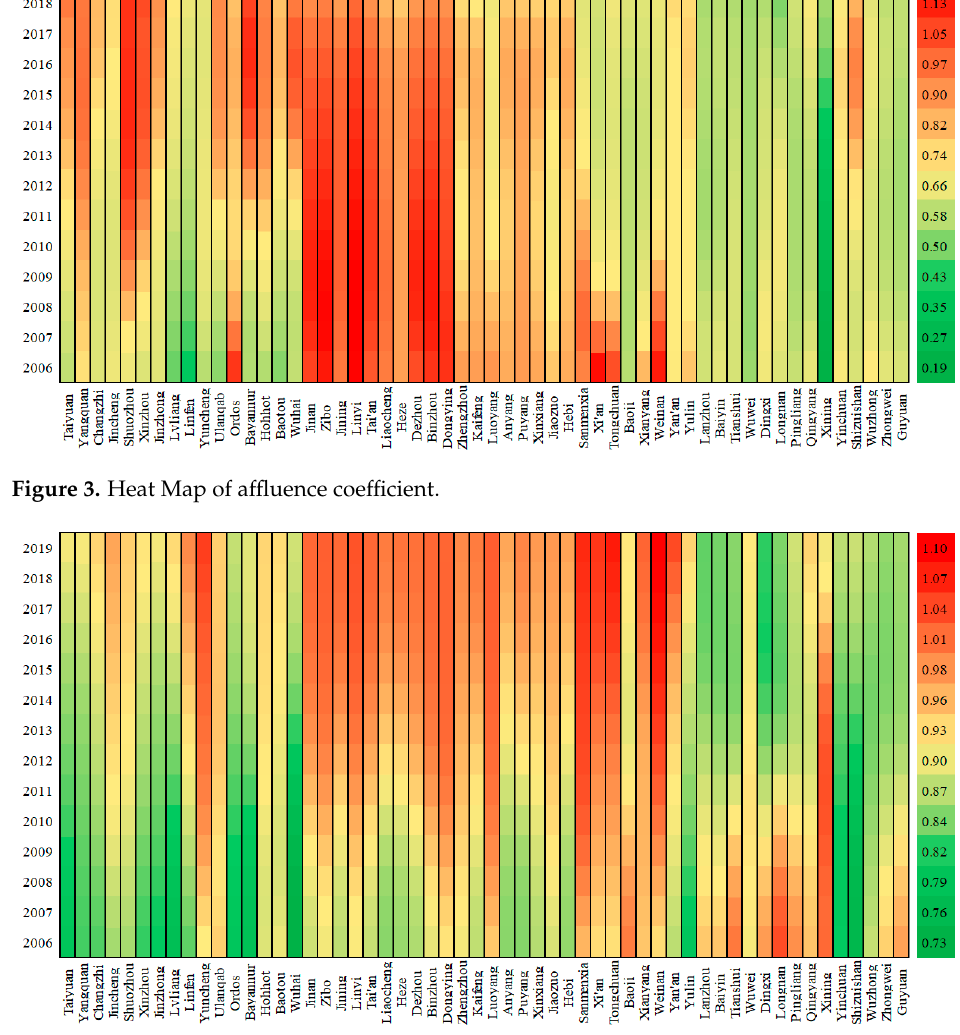
Figure 4. Heat Map of technology